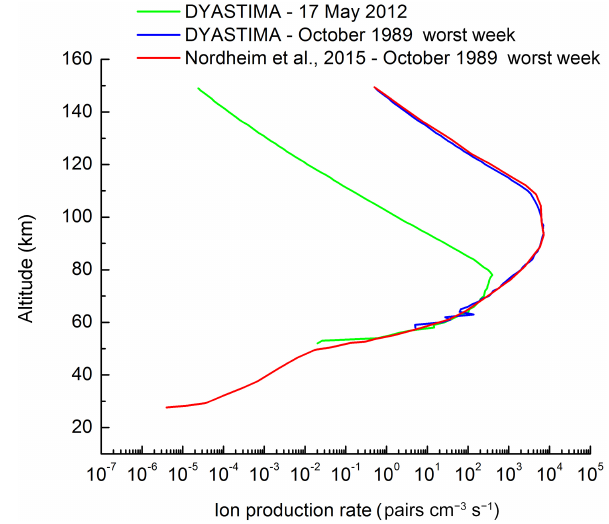
Figure 2. Ionization rate profiles in the Venusian atmosphere due to the arrival and penetration of SEPs during different events. For the event in October 1989 the results of the current study obtained with DYASTIMA (blue line) and the results by Nordheim et al. (2015) (red line), both refer to the event’s “worst week”. The results of the application of DYASTIMA to the May 2012 SEP event (green line) refer to the “main phase” of the event, i.e. after the peak time of the low-energy (of at least 100MeV) proton fluxes (see also Table